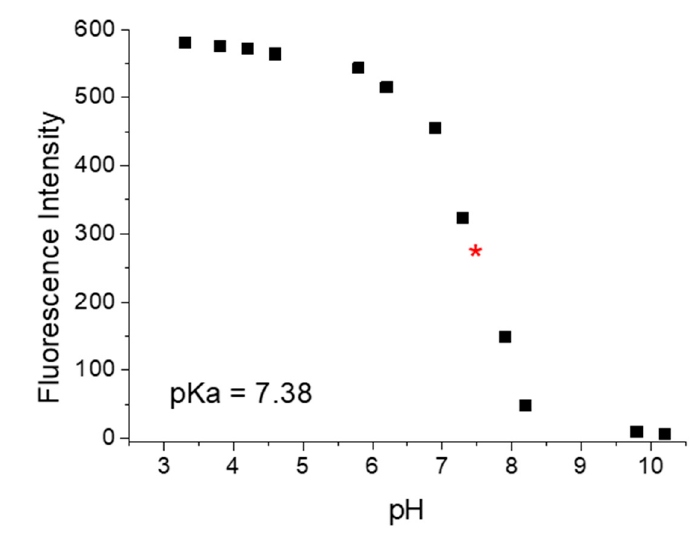
/ water (1:4, v / v ) solution. Sensors 2020 , 20 , x FOR PEER REVIEW 11 of 18